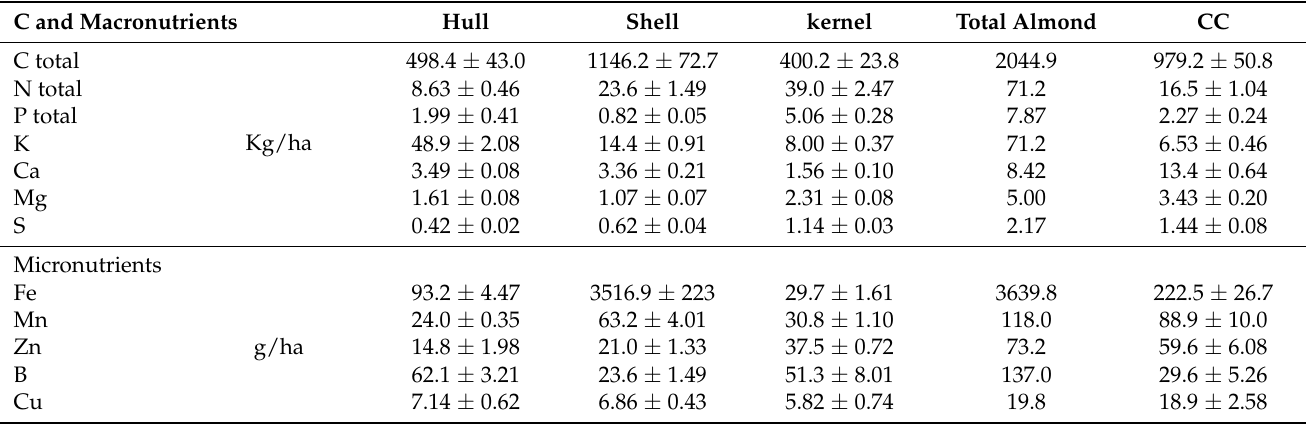
Table 4. Carbon and mineral nutrient uptake in the trees with farmer fertigation and bare soil management and sequestration of nutrients in the shoot of the cover crops (CC). Data shows the mean ± standard